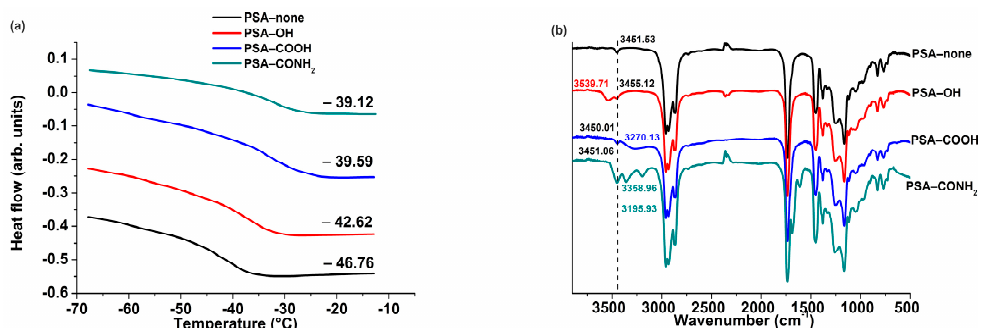
Figure 3. ( a ) Glass transition temperatures ( T g ) of four PSAs; ( b ) FTIR spectra of the characteristic peaks of four PSAs.